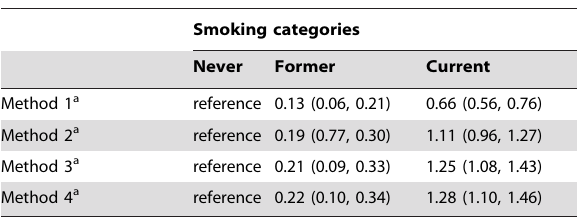
Table 3. Regression coefficients and 95% CI of smoking status in relation to Disability-Adjusted Life Years (DALYs) in 33,507 EPIC-NL participants.